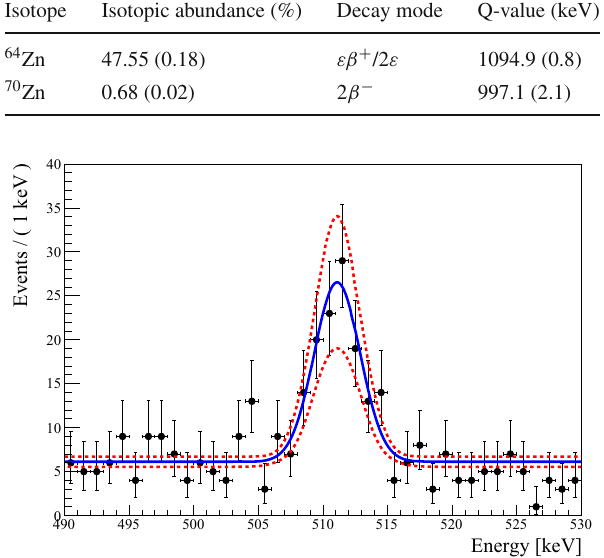
Fig. 3 Energy spectra focused on 511 keV peak. Data acquired by the GeMPI-4 ULB-HPGe spectrometer with the zinc sample over 827.66 h. The blue line marks the best fit result, while the red dashed lines report a 1 σ